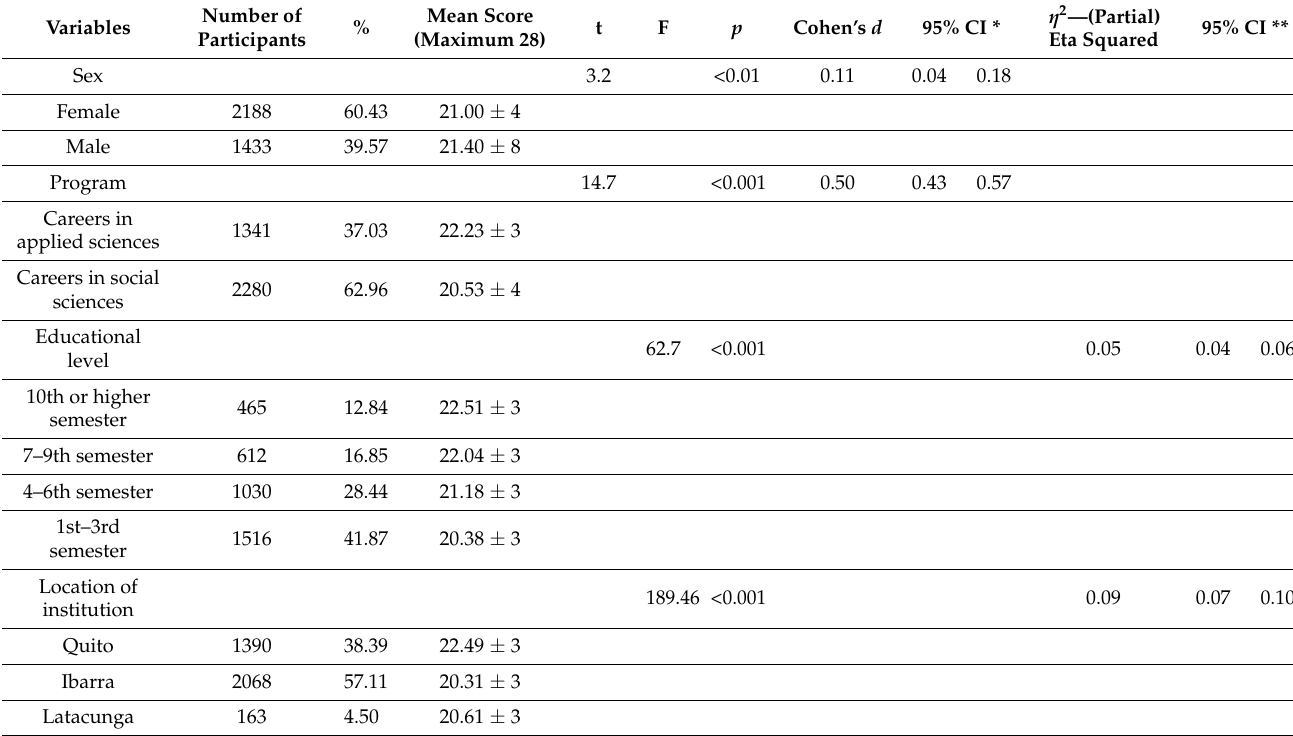
Table 1. Demographics of students and scores.